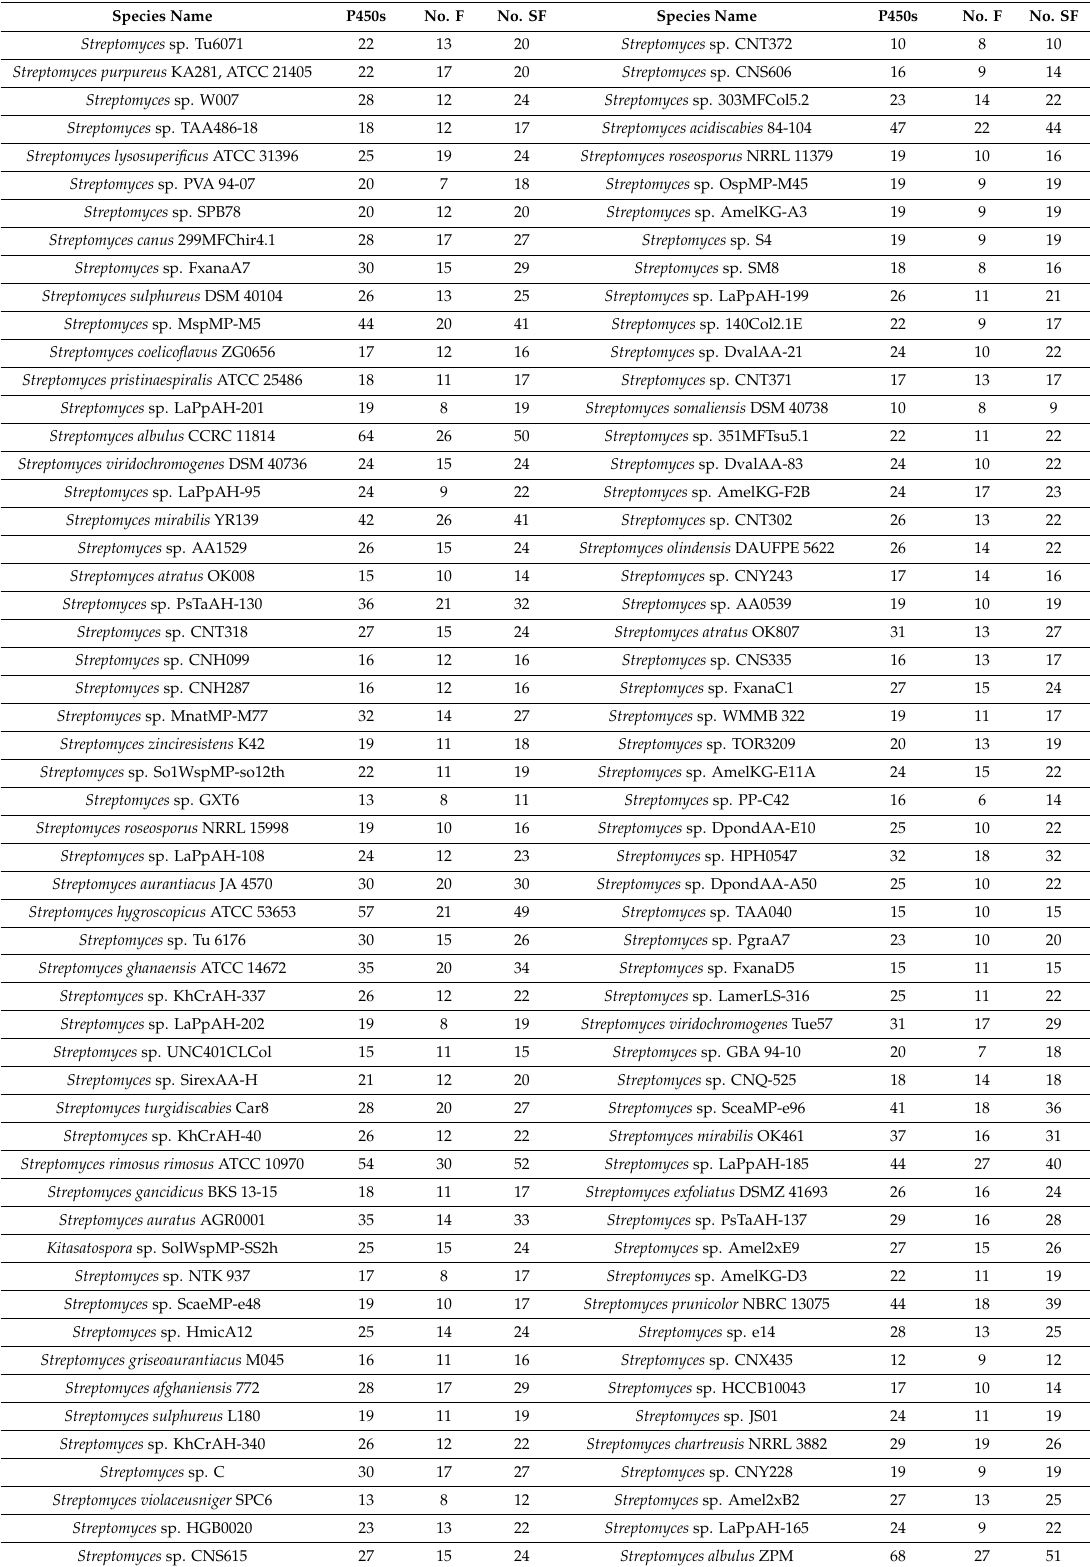
Table 1. Genome-wide data mining and annotation of P450s in 203 Streptomyces